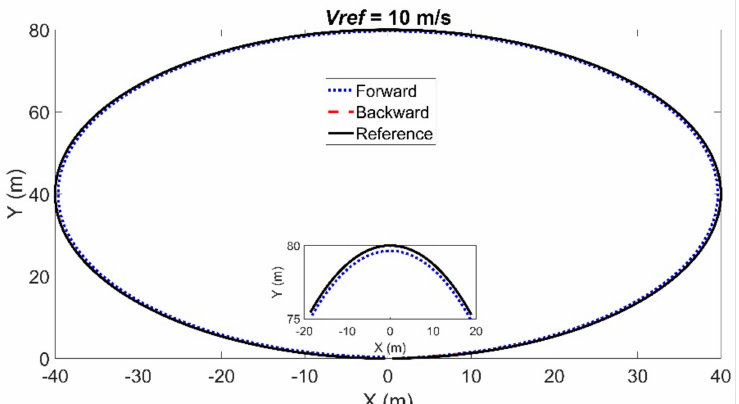
Figure 8. Simulation results for the circular path with radius Rd = 40 m. Notations the same as in Figure 4.